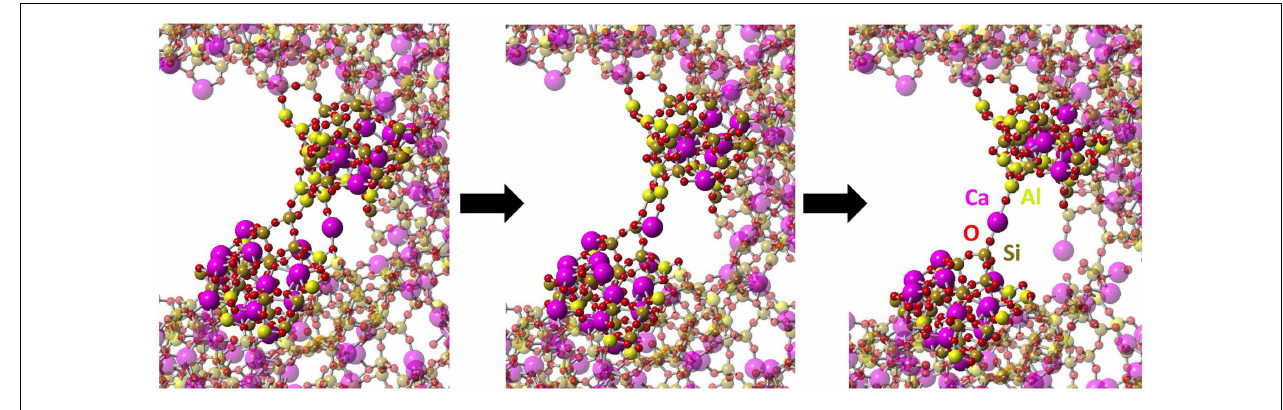
after the strain is increased to 27%, and the right shows the further equilibrated structure under 27% strain. Atomic types are marked on the last